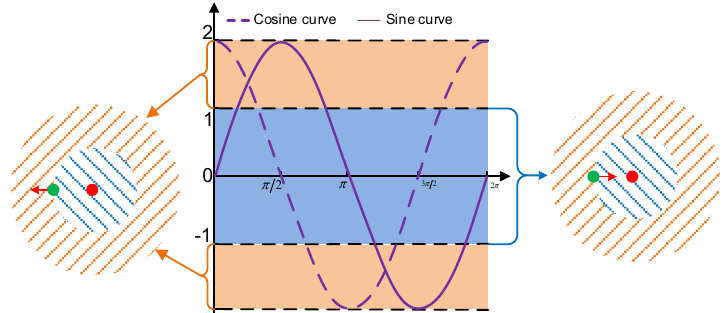
Figure 1. Diagram of SCA search